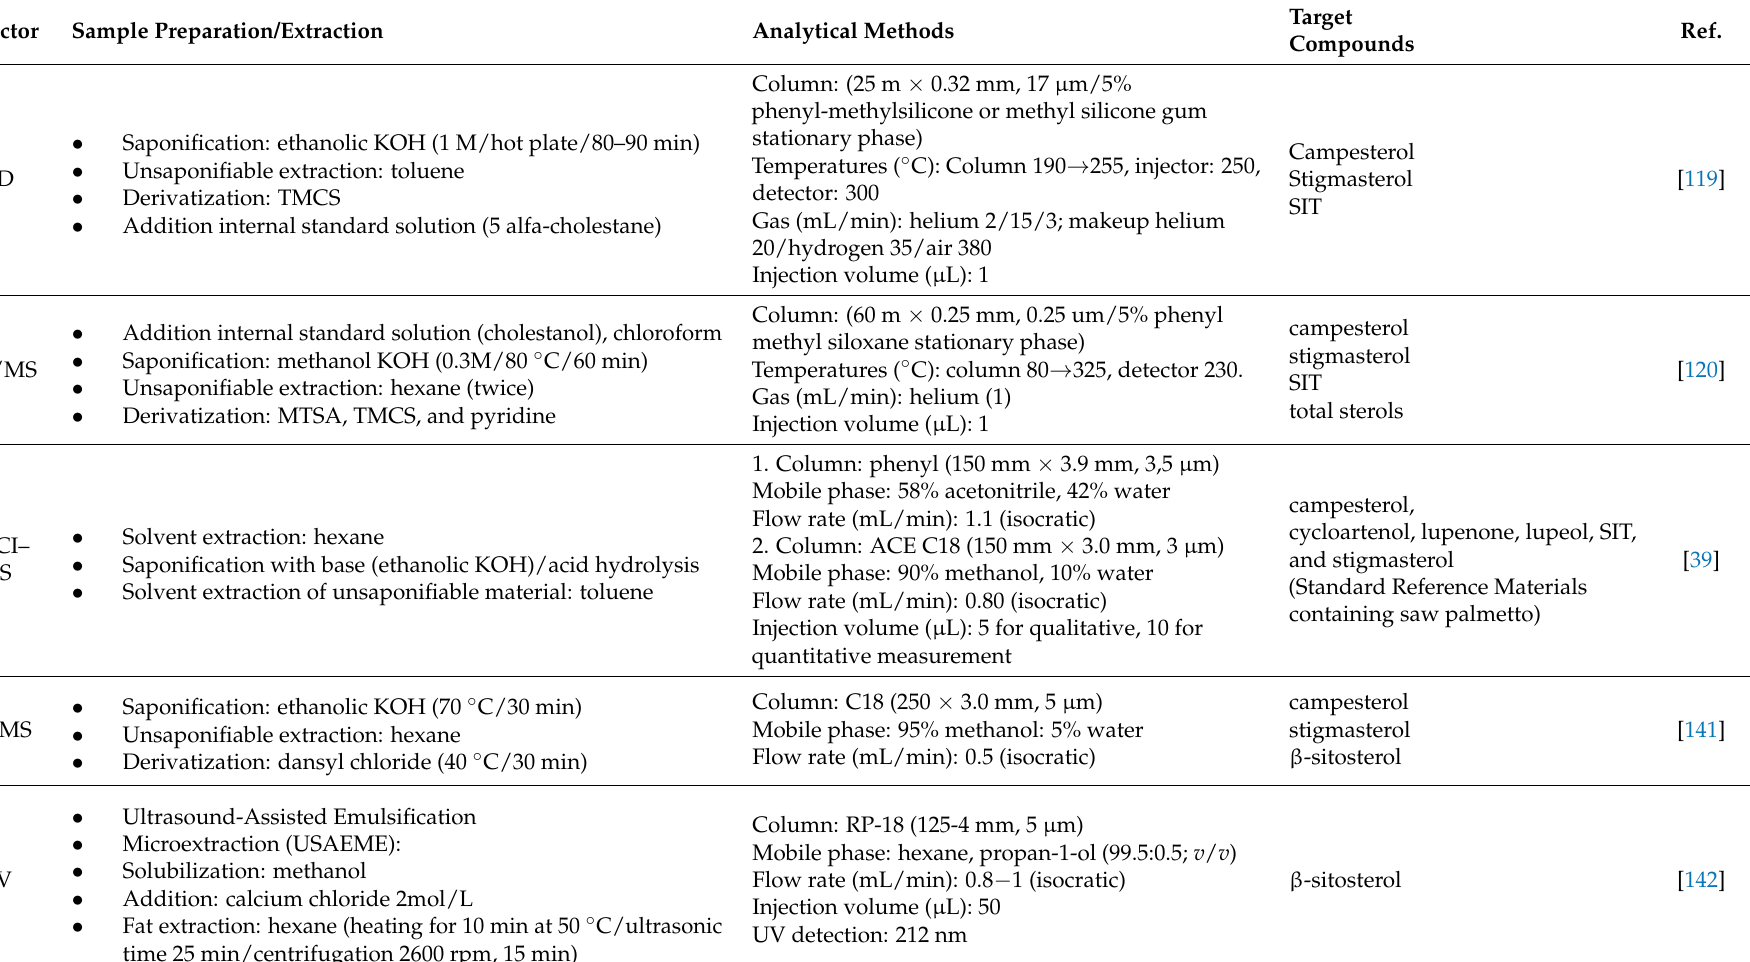
Table 4. Cont . Method Detector Sample Preparation/Extraction Analytical